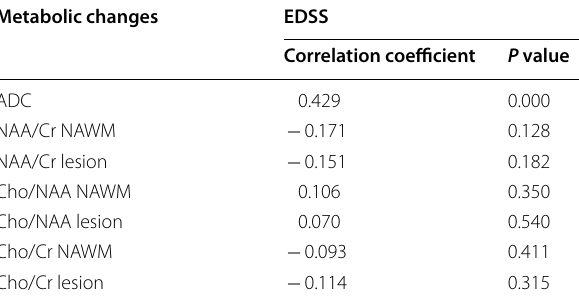
Cho/Cr choline/creatine; Cho/NAA choline/ N -acetyl-aspartate; EDSS expanded disability status scale; NAA/Cr N -acetyl-aspartate/creatine; NAWM